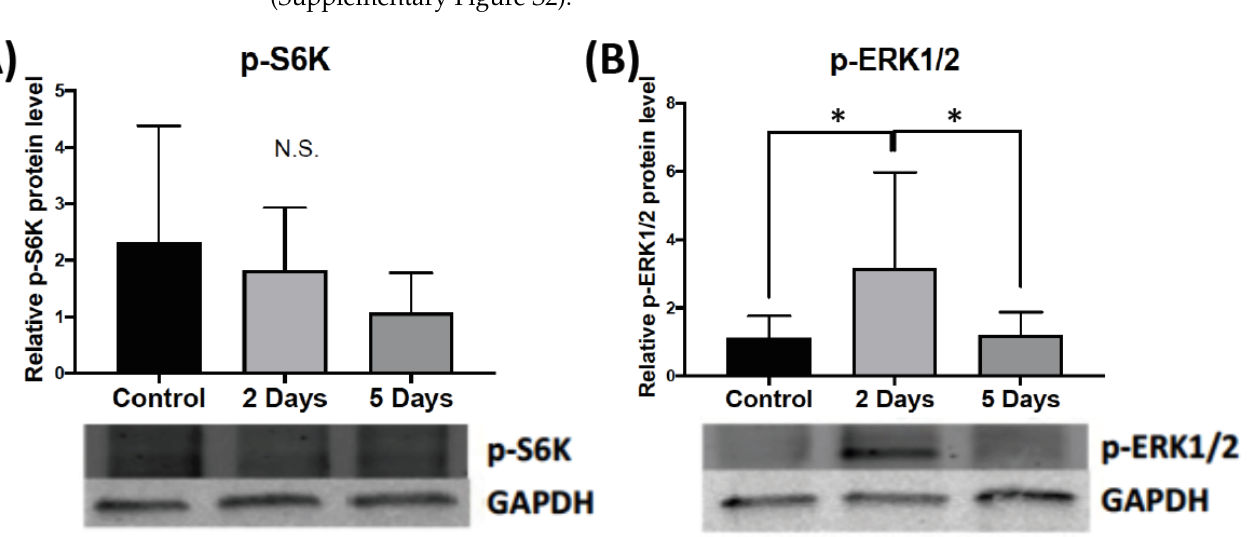
Figure 2. The effect of aggressive interactions on the phosphorylation and the expression of intra- cellular signaling molecules that regulate Fragile X Mental Retardation Protein (FMRP) in the nu- cleus accumbens (NAc). ( A ) There is no change in the phosphorylation of ribosomal S6 kinase (S6K) (phosphorylates FMRP) in the NAc 10 min following either 2 or 5 consecutive days of ag- gressive interactions compared to control female Syrian hamsters that had no social interaction experience (N.S.). ( B ) There is an increase in the phosphorylation of extracellular-signal related ki- nase 1/2 (ERK1/2) 10 min following 2 days of aggressive interactions compared to control female Syrian hamsters that had no social interaction experience and compared to levels following 5 days of aggressive interactions (* p < 0.05). ( C ) However, there was no change in the overall protein ex- pression of ERK1/2 in the NAc (N.S.). ( D ) There is an increase in the ratio of the phosphorylation of ERK1/2 to the phosphorylation of S6K in the NAc following two and five days of aggressive in- teractions compared to female hamsters that had no social interaction experience (* p < 0.05). (Con- trol n = 7 – 8, 2 Days n = 11, 5 Days n = 11). Data are presented as mean +/ − standard deviation.